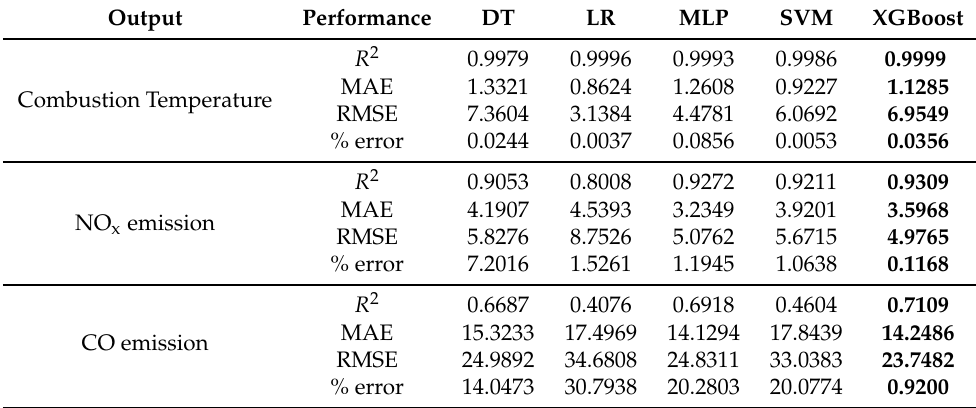
Table 4. Performance evaluation of regression model.